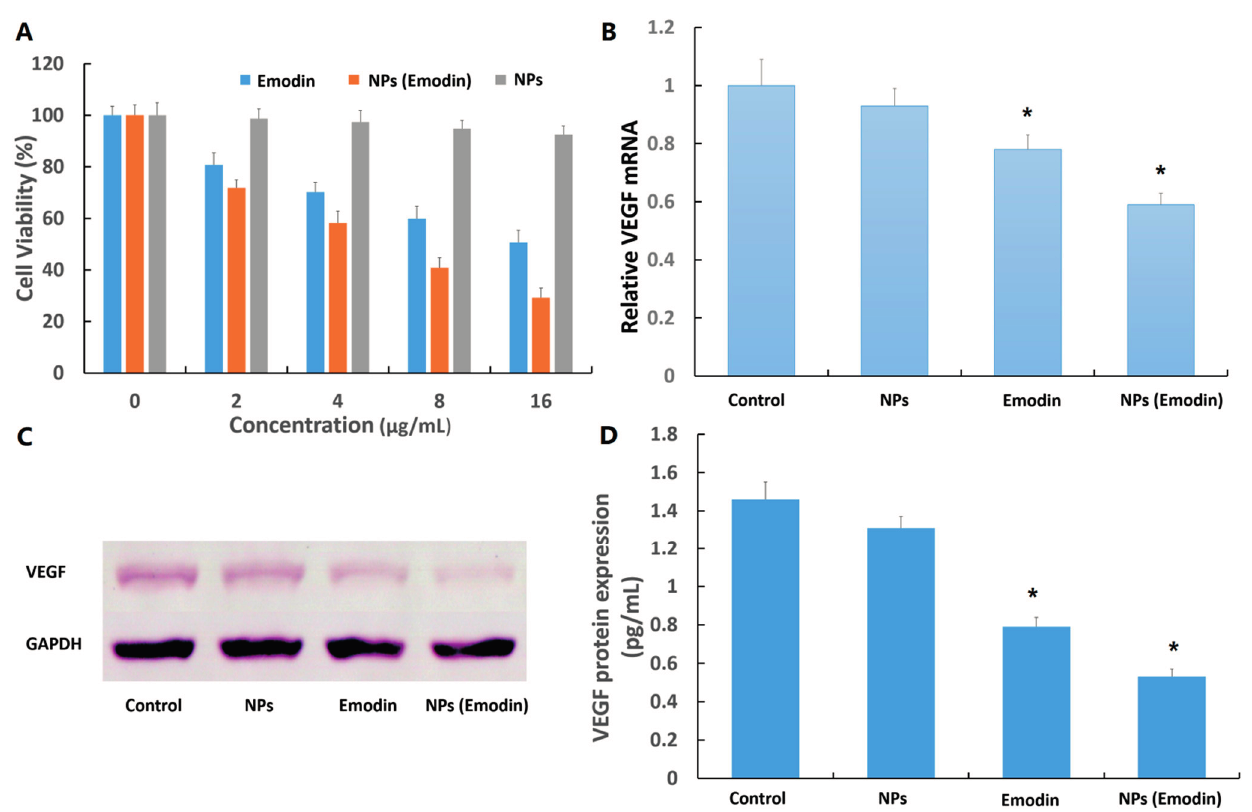
Figure 5. ( A ) Viability of cells incubated with emodin and emodin–MgSiO 3 under different incubation concentrations; ( B ) VEGF (vascular endothelial growth factor) mRNA expression of cells; ( C ) VEGF protein expression measured by western blot; and ( D ) enzyme-linked immunosorbent assay (ELISA) analysis for VEGF protein expression. ( * p <